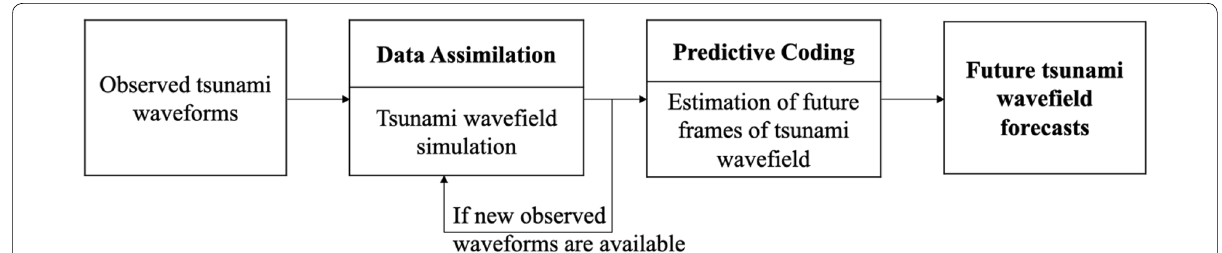
Fig. 2 Schematic of the joint DA-predictive coding